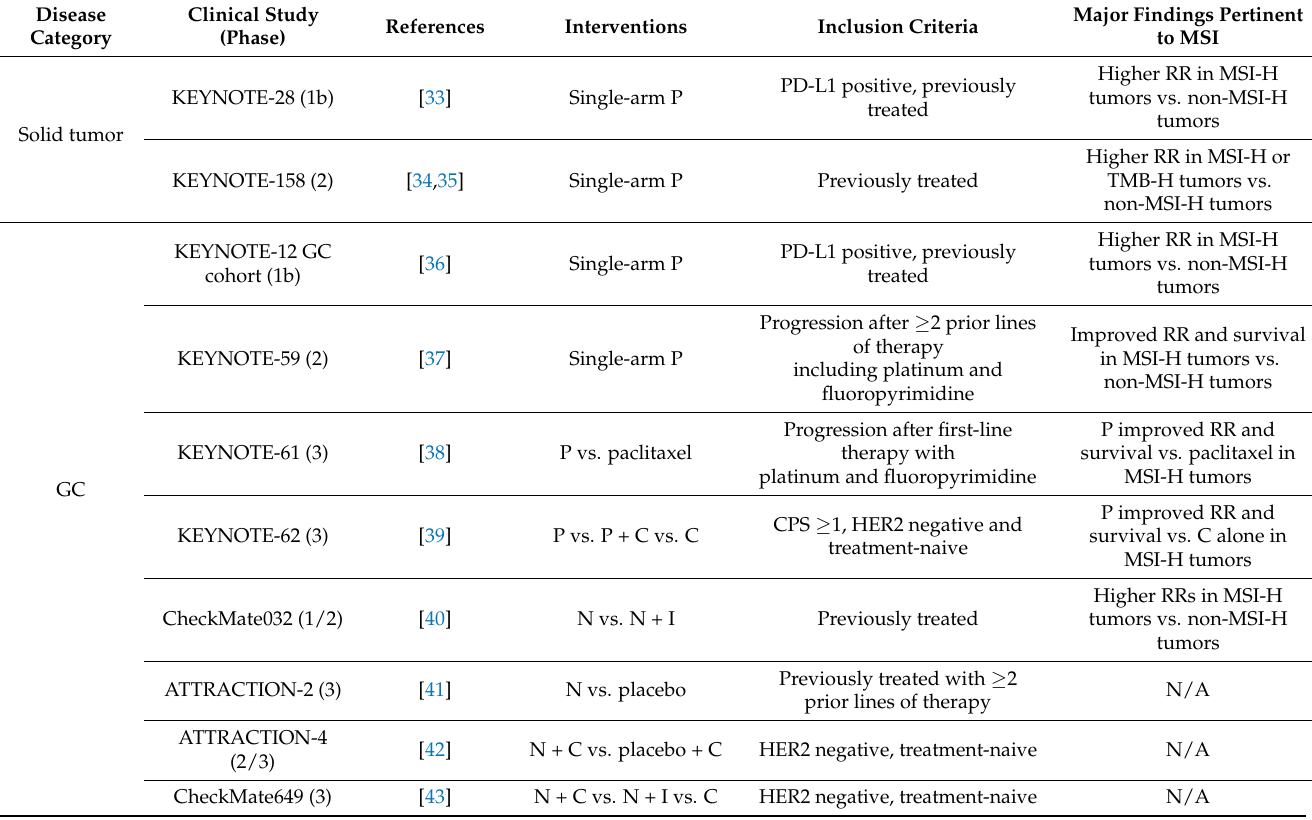
Table 2. Major clinical trials involving immune checkpoint inhibitors in non-colorectal gastrointestinal cancers. Disease Clinical Study Category